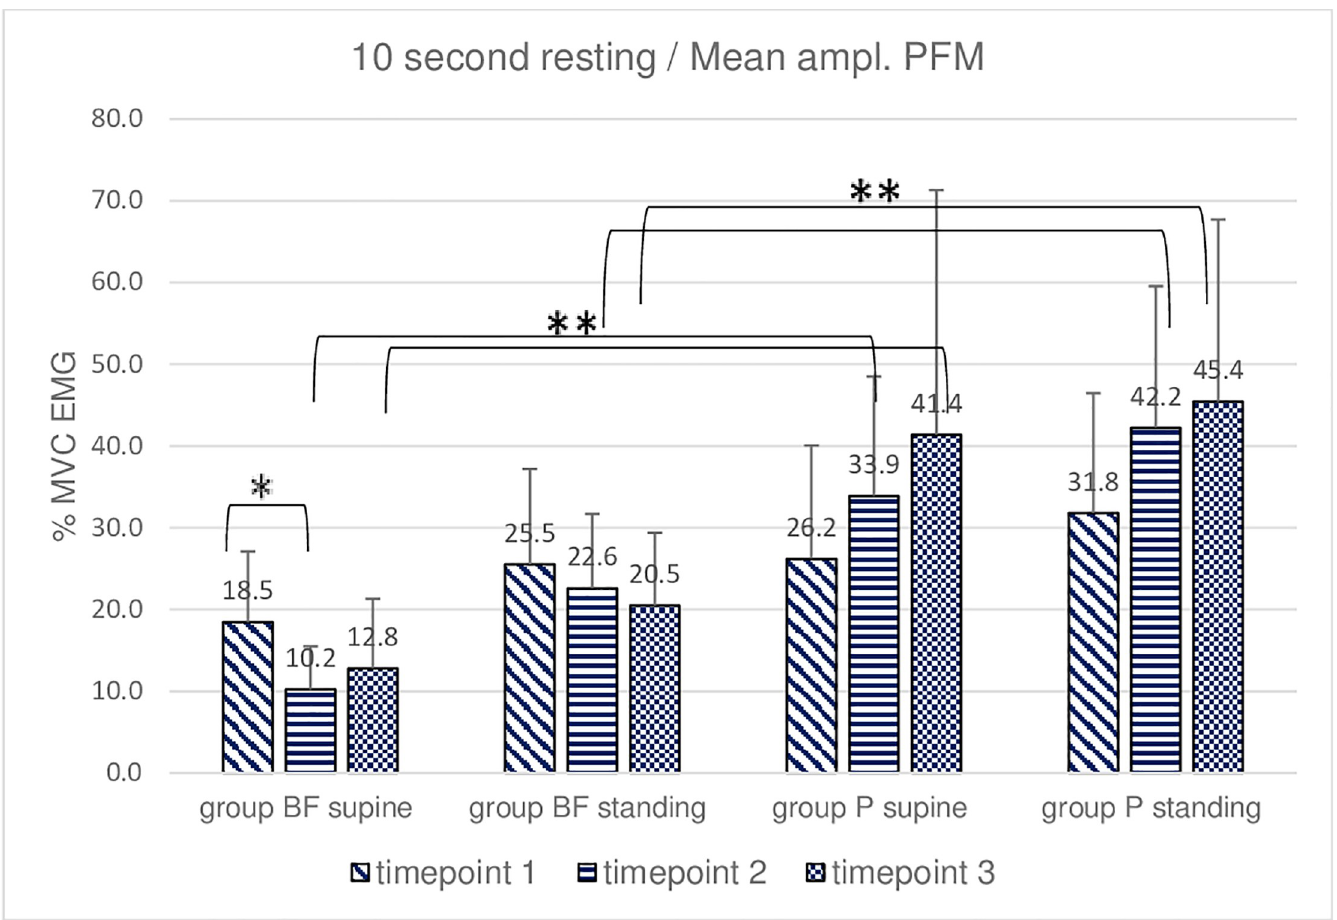
Fig 1. Intra- and intergroup analysis of sEMG mean %MVC amplitudes of the resting activity of pelvic floor muscles; p � Post-hoc Friedman’s rank sum test; p �� Mann- Whitney U